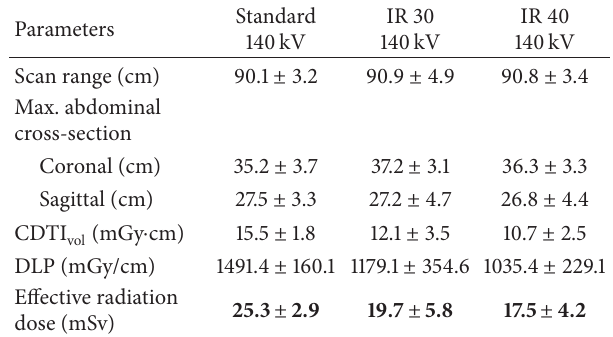
Table 1: Radiation